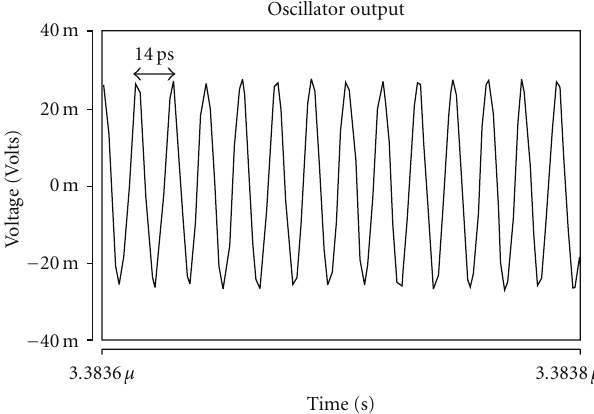
Figure 11: Transient output of the CMOS negative resistance bu ff er-cell oscillator of Figure 8 indicating a time period of around 14